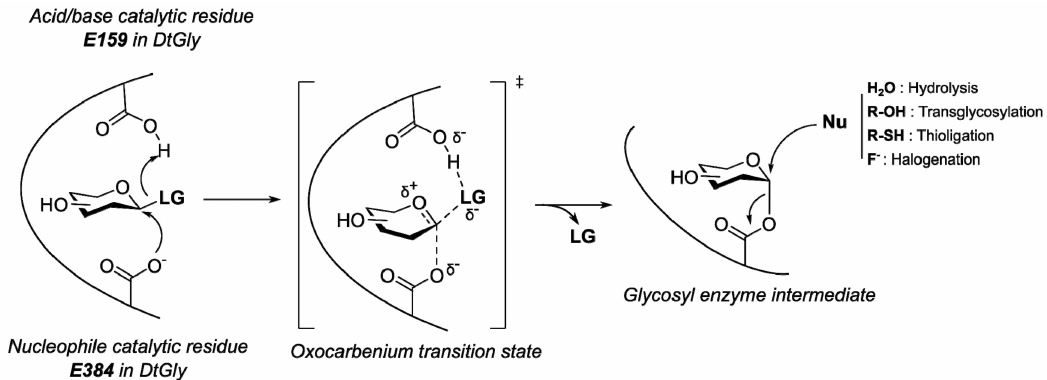
Figure 1. Schematic mechanism of the first step involving the glycosyl-enzyme intermediate formation in retaining GH. The leaving group (LG) release can also be catalysed through another catalytic residue according to its nature. Depending on the nucleophile (Nu) attacking the intermediate, three reactions can take place—hydrolysis, transglycosylation or thioligation.